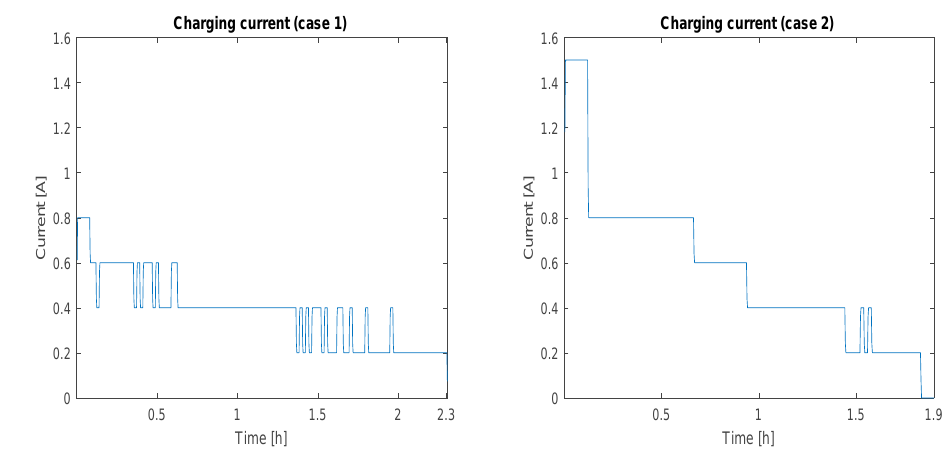
Figure 16. Practical implementation.